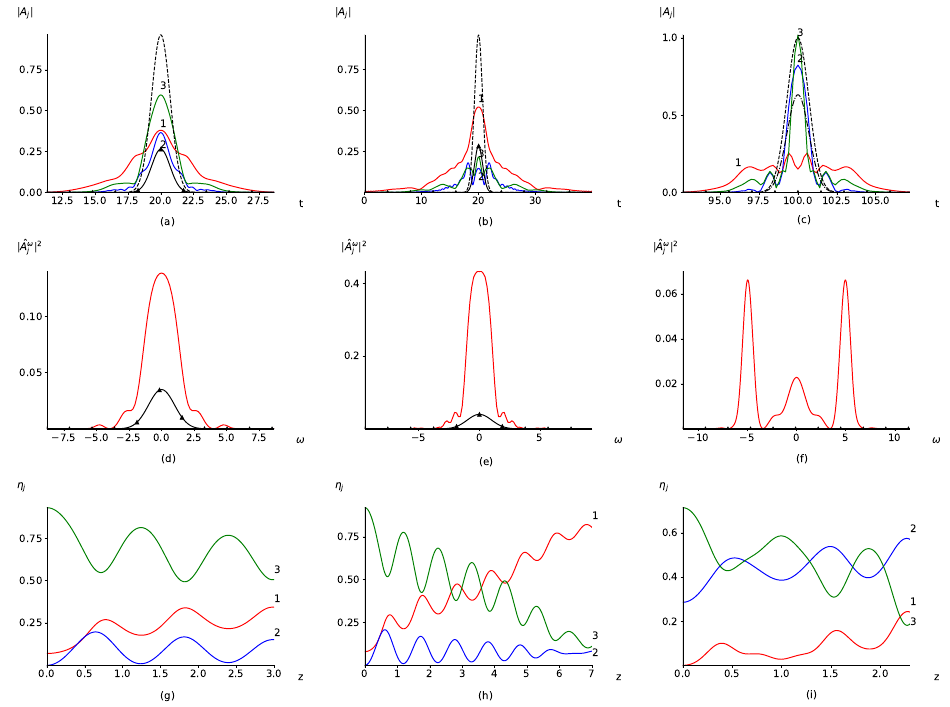
Figure 5. Pulse shapes in the section z = 3 ( a ), 7 ( b ), 2.5 ( c ), and the LFW Fourier spectrum ( d – f ), and the frequency conversion efficiency evolution ( g – i ) along the z -coordinate computed for ( | A | 2 , | A | 2 ) = ( 0.07, 0 ) ( a , d , g ), ( 0.08, 0 ) ( b , e , h ), ( 0, 0.4 ) ( c , f , i 20 10